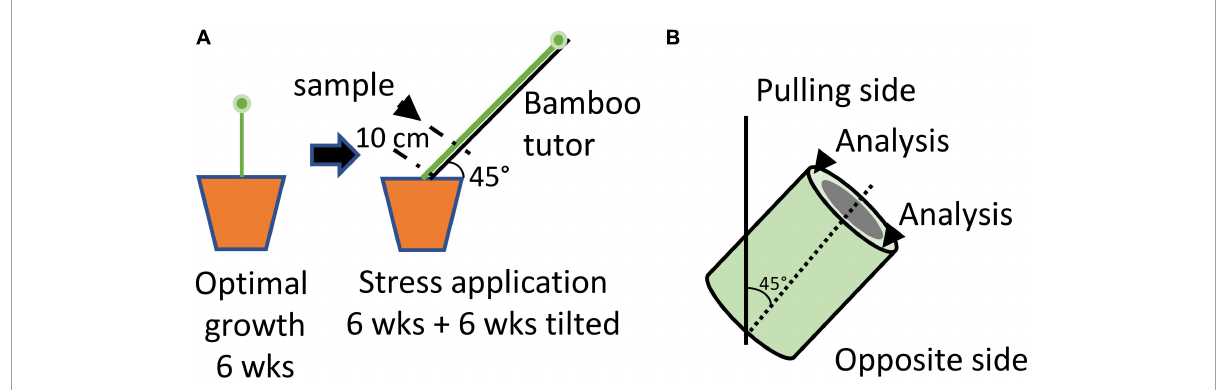
FIGURE1 Schematic diagram illustrating the growing conditions used to induce gravitropic stress in flax stems. (A) Protocol. Plants were grown under optimal conditions for 6 weeks before being attached to bamboo tutors inclined at an angle of 45 ◦ for a further 6 weeks. Attached plants were unable to recover to the vertical position. Samples (stem section) were collected at 10 cm above the cotyledon scars. (B) The upper side of the stem sample was considered as the “pulling side” and the lower side as the “opposite